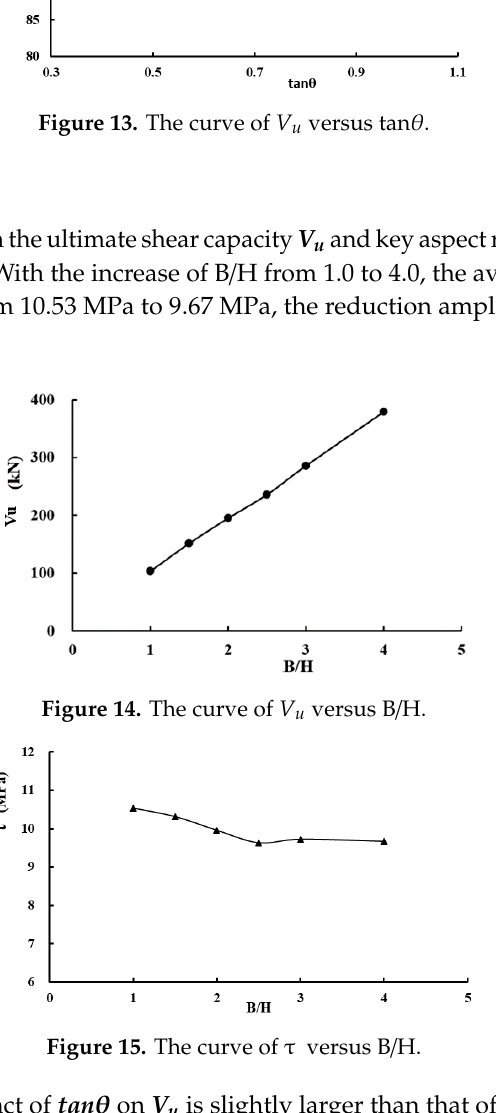
Figure 13. The curve of (cid:1848) (cid:3048) versus tan (cid:2016) .